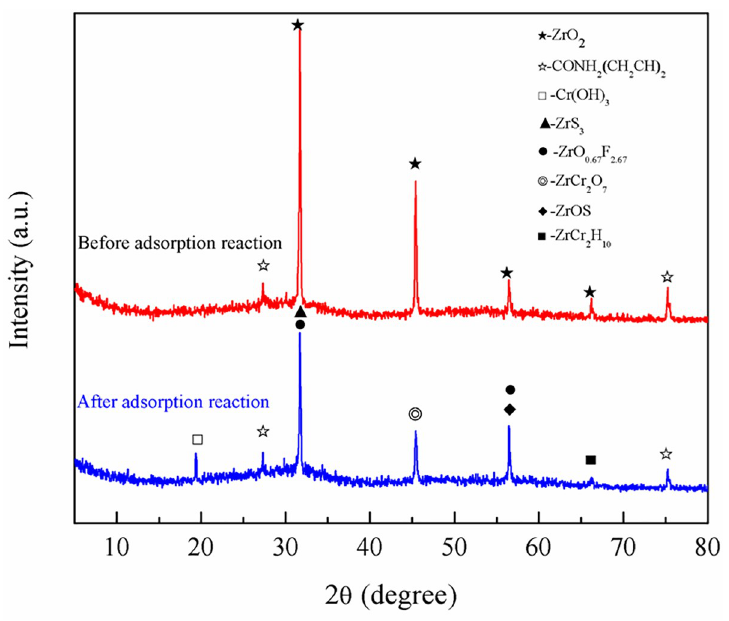
Fig 15. XRD patterns of ZPC particles before and after the adsorption reaction.